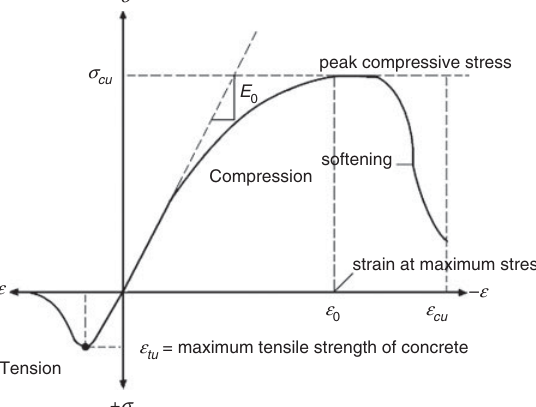
Fig 1. Stress – strain curve for steel Fig. 2. Stress – strain curve of